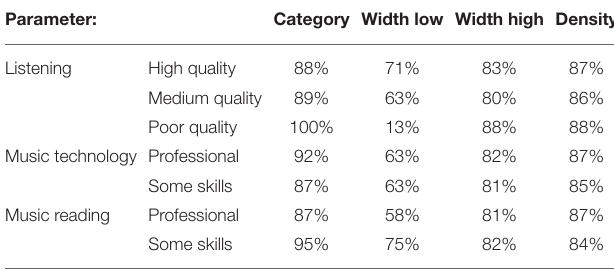
TABLE 2 | Amount of correct answers related to participant